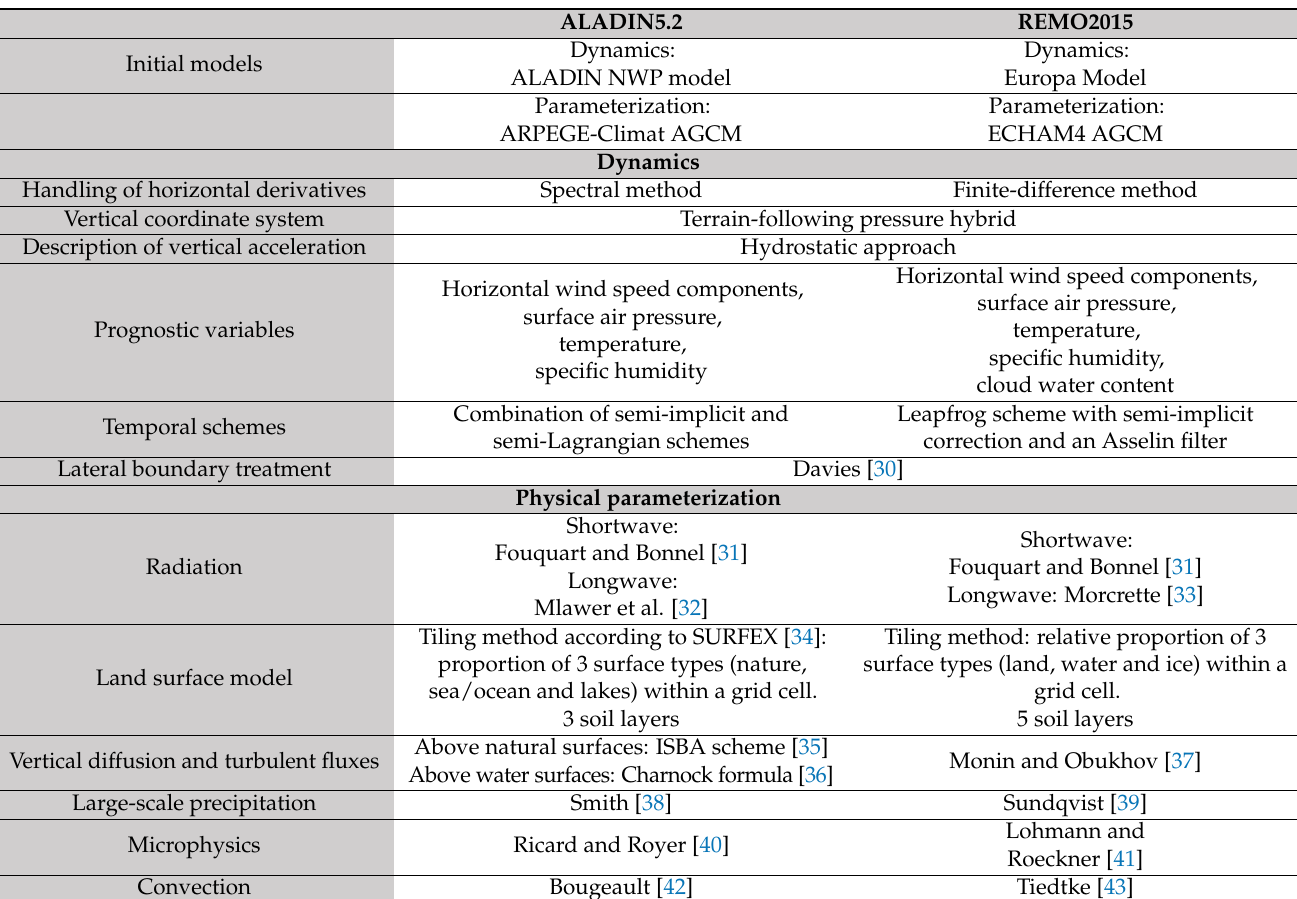
Table 1. Main features of the ALADIN5.2 and REMO2015 regional climate